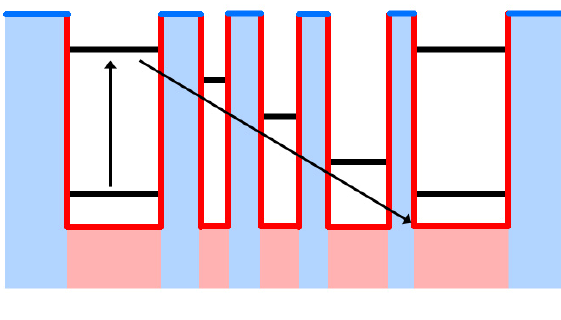
Figure 4. A band diagram of a quantum cascade detector. Incident light excites a carrier from the ground energy state of the absorbing well to an excited energy state. The